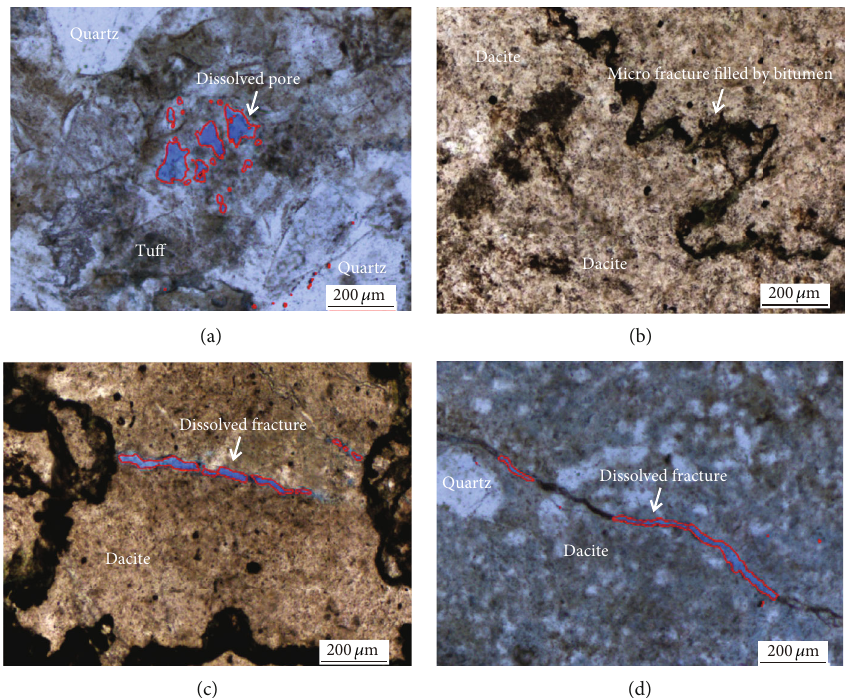
Figure 9: Thin section observed by plane-polarized and light perpendicular-polarized light for volcanic reservoir samples for the K 2700.0m, tu ff ; (b) 2240.0m, dacite; (c) 2240.9 m, dacite; (d) 2700.0m, tu ff